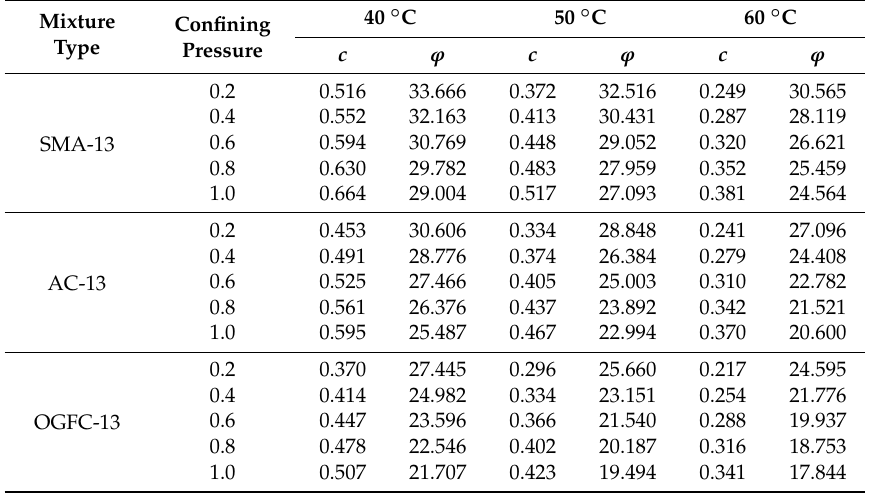
Table 9. Strength parameters of asphalt mixtures by nonlinear failure